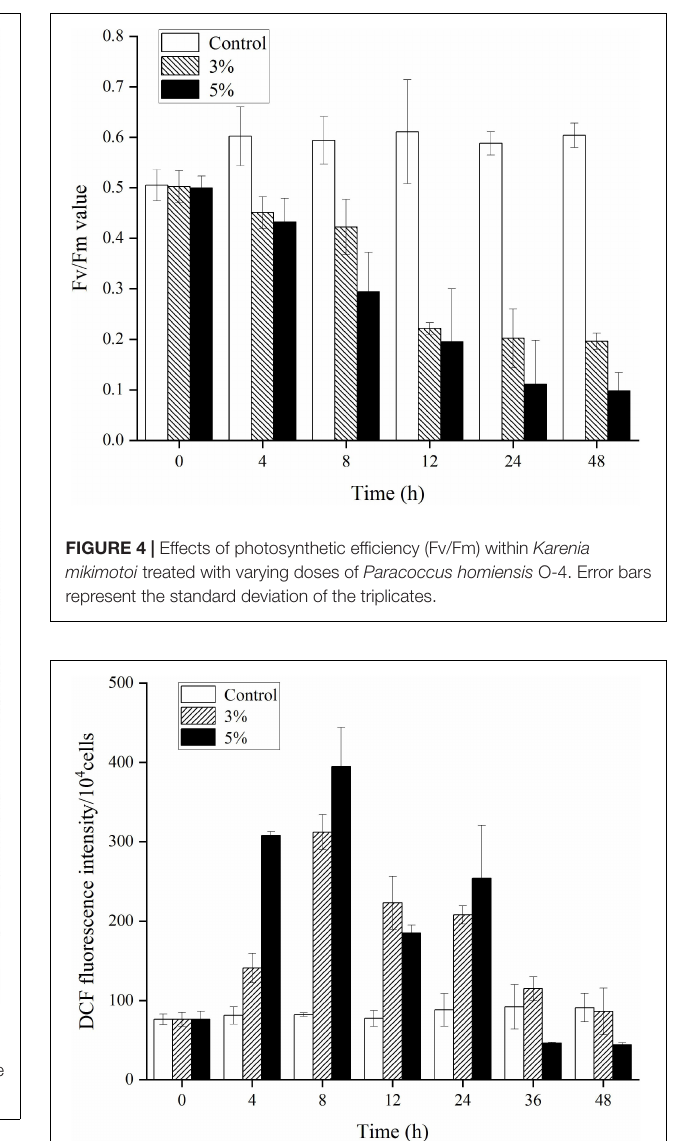
FIGURE 5 | Effects of ROS levels within Karenia mikimotoi after exposure to different doses of Paracoccus homiensis O-4. Error bars represent the standard deviation of the